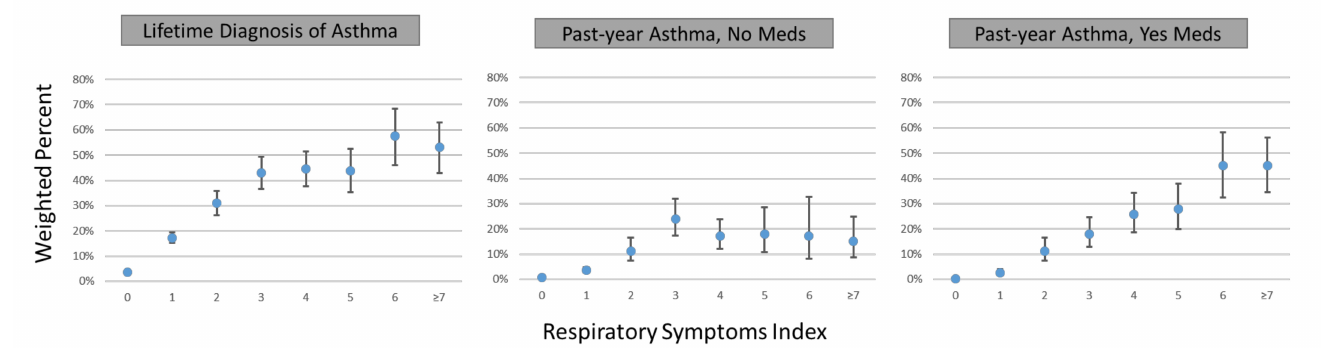
Figure 2. Weighted relationship between respiratory symptoms index score and self-reported asthma, Wave 2 (2014–2015) of the Population Assessment of Tobacco and Health (PATH) Study. PATH Study asthma outcomes illustrated in the figure: Lifetime Asthma (Unweighted n = 1829/16,295). Past-Year Asthma, No Meds (Unweighted n = 436/14,902). Past-Year Asthma, Yes Meds (Unweighted n = 371/14,837.